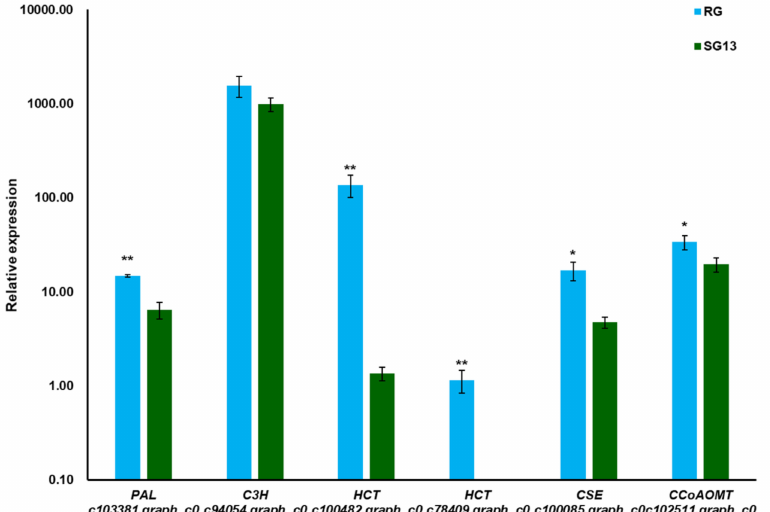
Figure 7. qPCR analysis of chlorogenate accumulation-related genes in RG and SG13. The gene expression was determined by fold change relative to the reference gene EF1 α . Values are means of three biological repeats. Error bars indicate ± SE. Statistical significance was determined by t -tests, * and ** above the bar represent significant difference ( p < 0.05) and extremely significant difference ( p < 0.01),